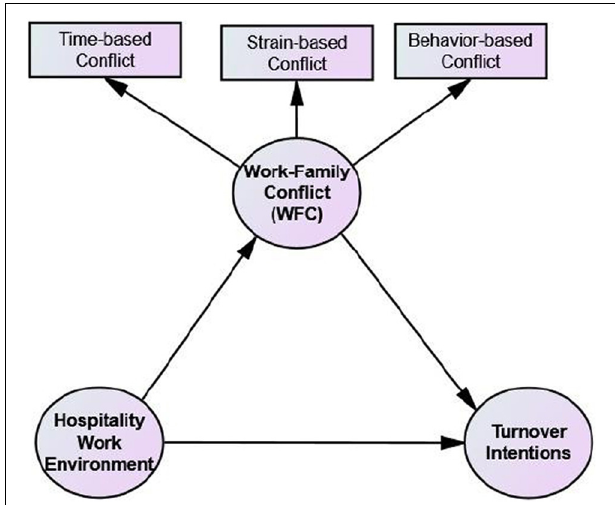
FIGURE 1 | The conceptual model of